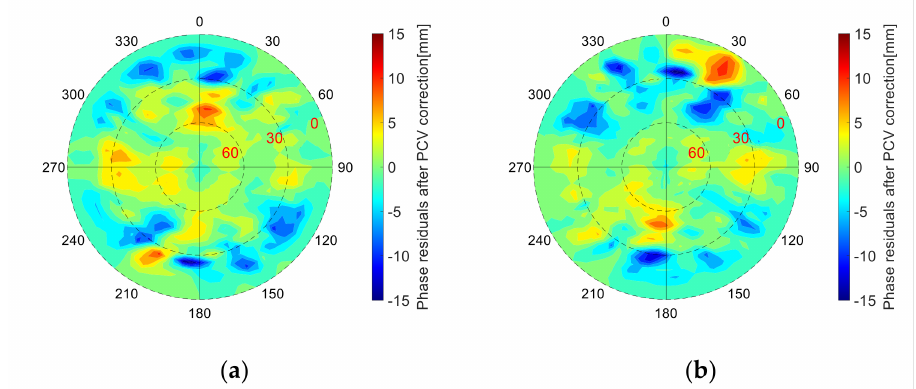
Figure 2. The 5 ◦ × 5 ◦ PCV corrections of ( a ) GRCC and ( b ) GRCD satellites based on ionosphere free carrier phase residuals from the DD AR solution.